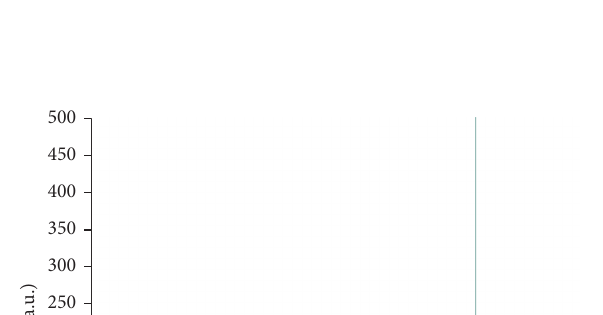
F 3: HPTLC chromatogram of the acid-induced degradation of LAM (200ng/spot).